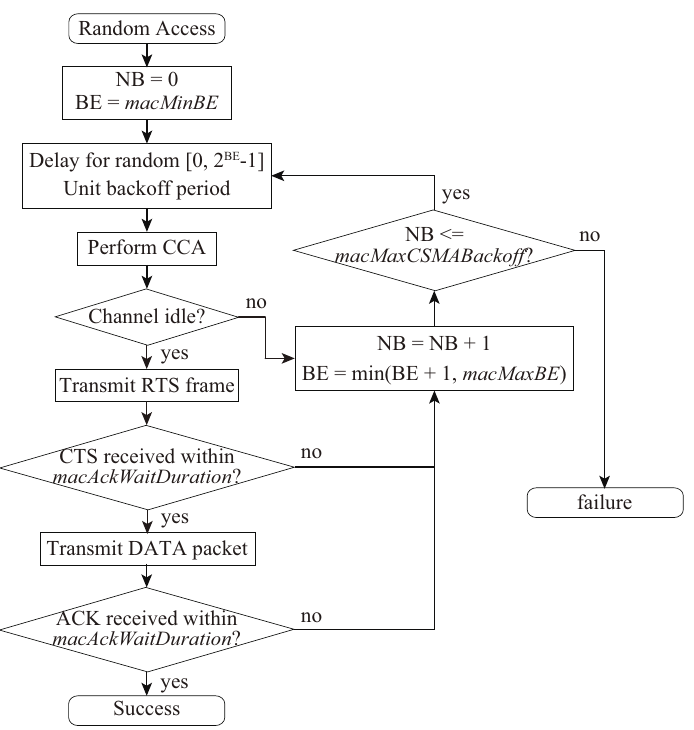
Figure 1. Random–access procedure for the CSMA/CA in IEEE 802.15.7